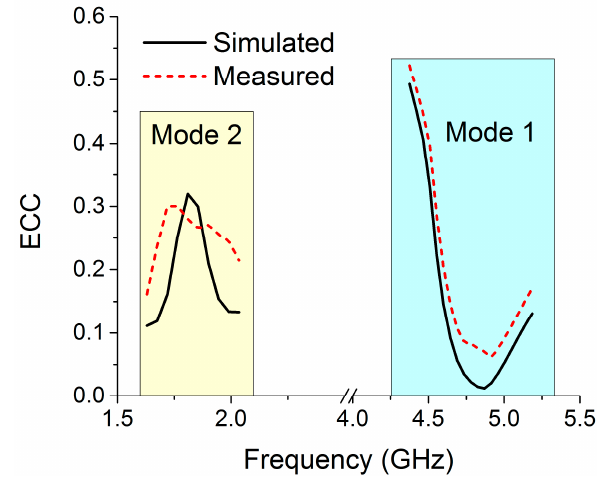
Figure 30. ECCs for the MIMO antenna in both modes.